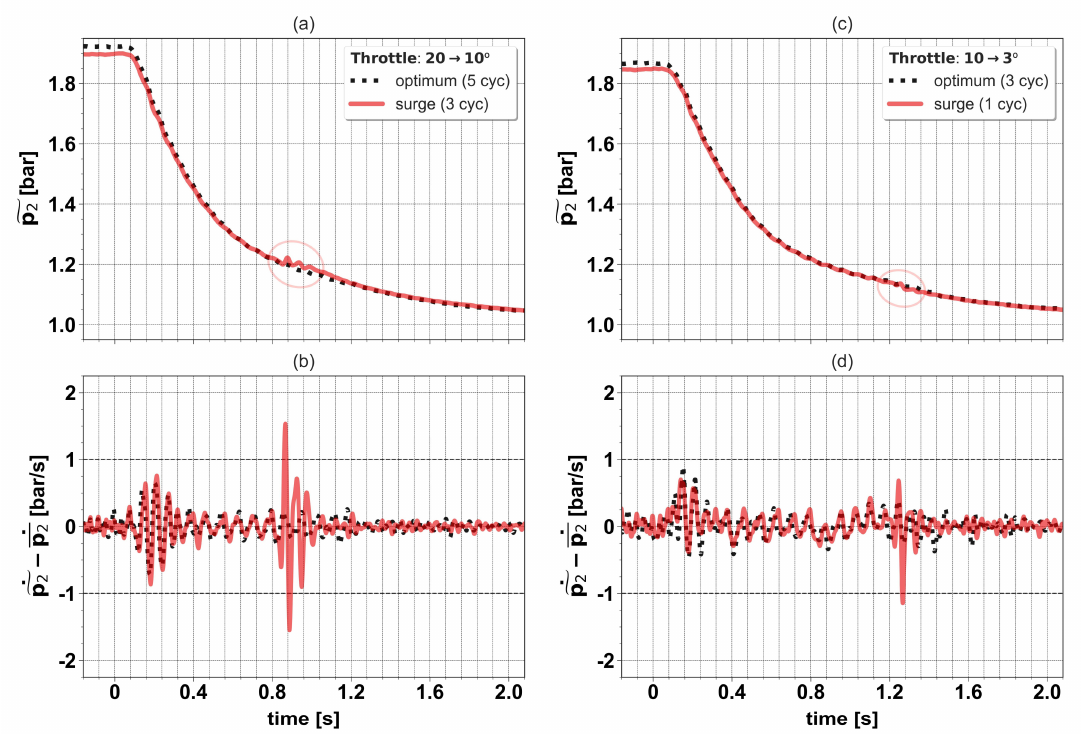
Figure 4. Time evolution of compressor outlet pressure and its time derivative for two cases of the transitions 20–10 ◦ ( a , b ) and 10–3 ◦ ( c , d ). In the insets, the duration of the transition is stated between parentheses.